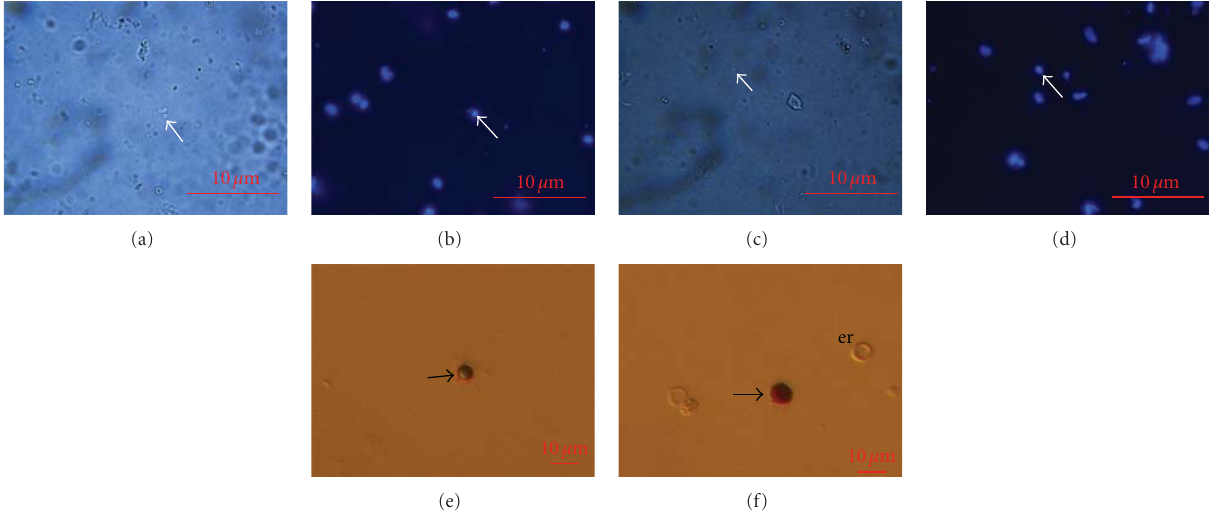
Figure 4: Small round cells (arrows)—putative stem cells in a population of cells scraped from the ovarian surface epithelium. (a) Just after scraping (magnification 100-times). (b) After DAPI staining (magnification 100-times). (c) Just after scraping (magnification 100-times). (d) After DAPI staining (magnification 100-times). (e) Weakly-stained small round cell-putative stem cell after Giemsa staining (magnification 200-times). (f) Blue-stained lymphocyte (arrow) after Giemsa staining (magnification 200-times). (Light, fluorescent, inverted